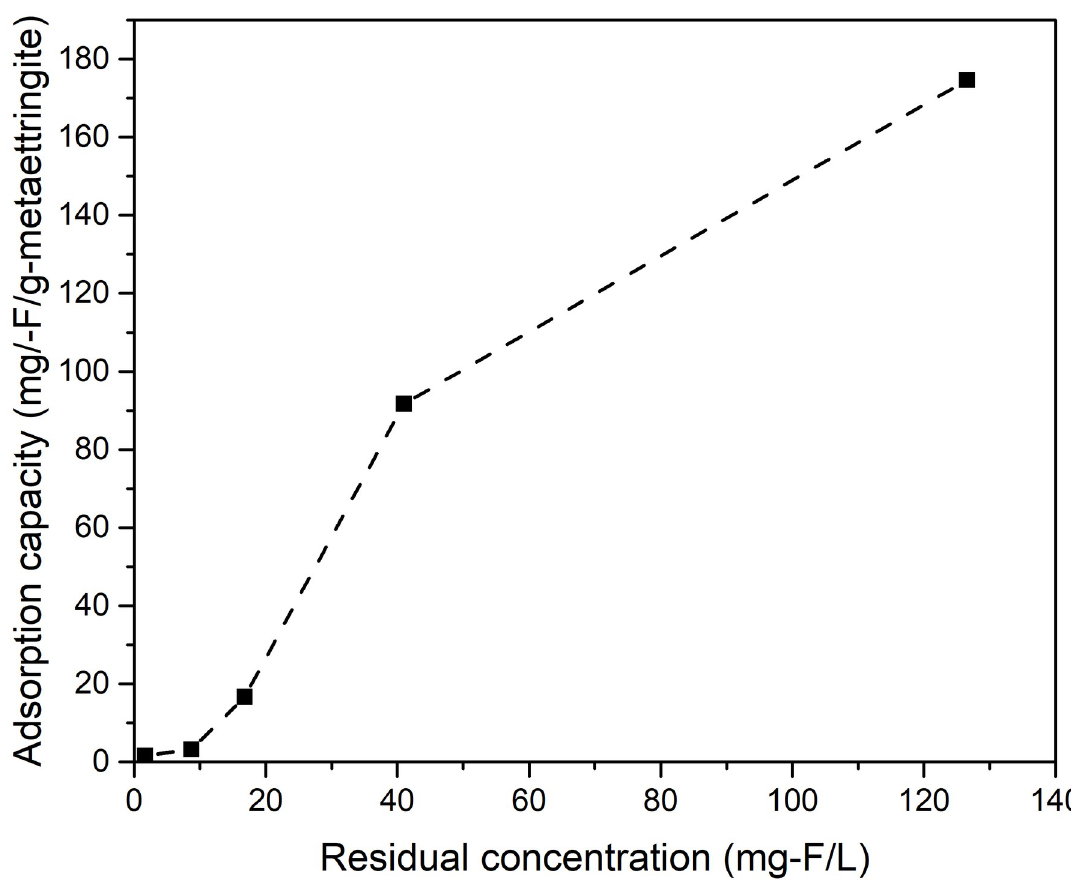
Fig 8. Adsorption isotherm of fluoride on